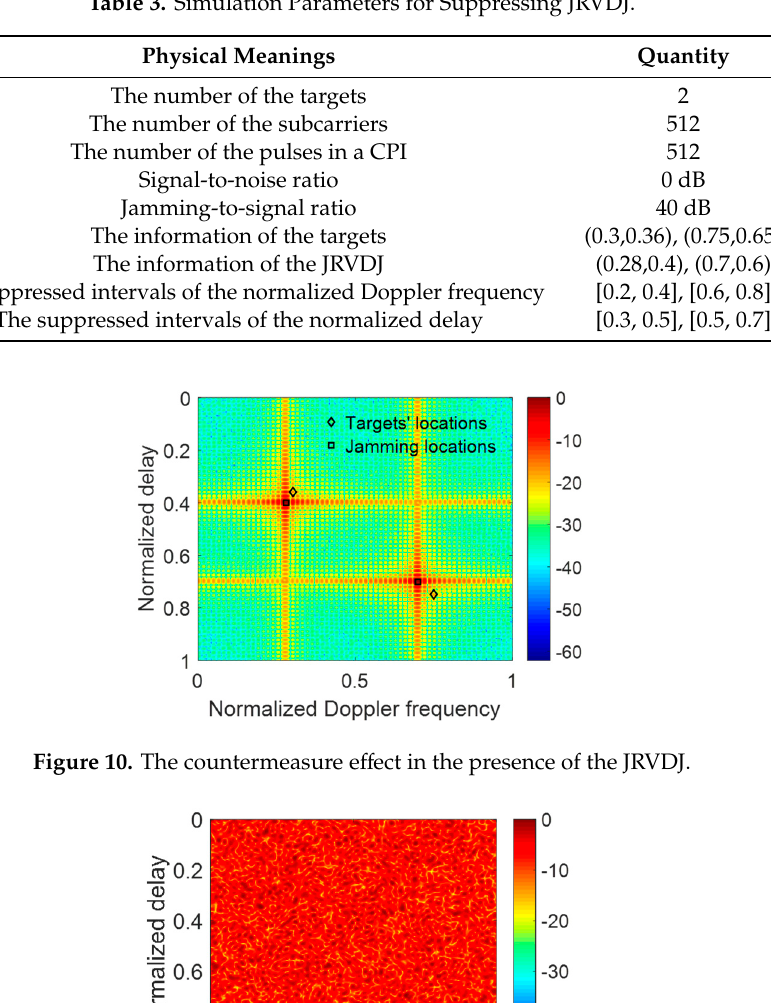
Table 3. Simulation Parameters for Suppressing JRVDJ.